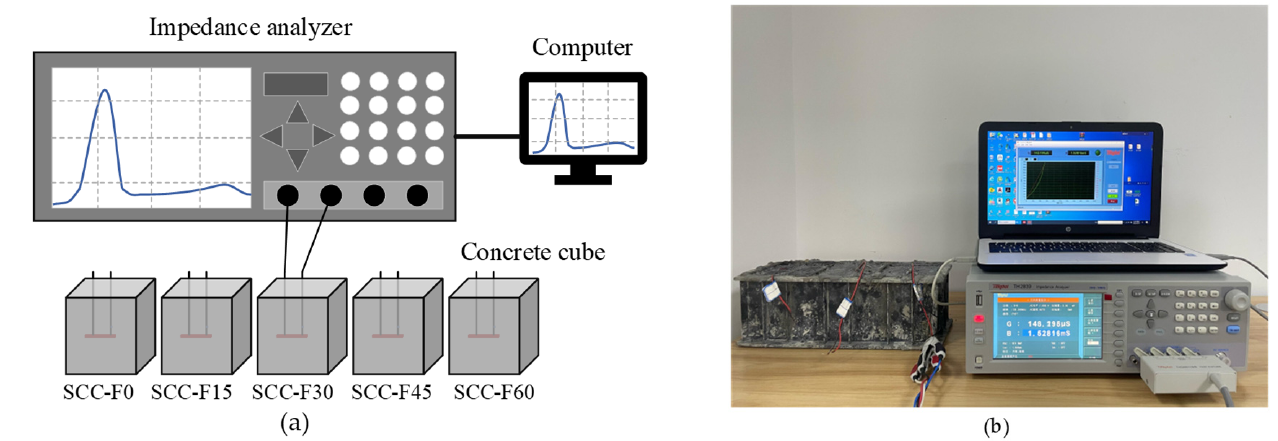
Figure 5. Schematic diagram ( a ) and equipment ( b ) of the electromechanical admittance testing system.